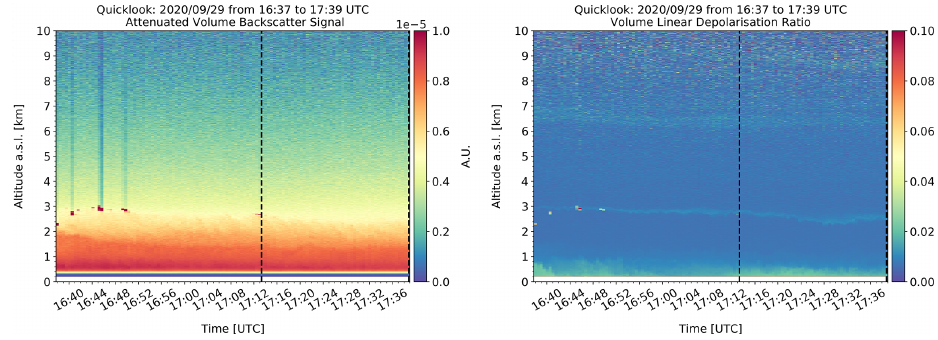
Figure 8. Height versus time plots of the attenuated volume backscatter signal from linear emission and the volume linear depolarisation ratio at 355nm over Athens, measured by eVe lidar on 29 September 2020 from 16:37 to 17:39UTC. The raw temporal and vertical resolution are 30s and 3.75m, respectively, with vertical pointing of the system. The attenuated volume backscatter signal was calibrated using a calibration factor averaged inside the selected time frame and calculated at 3.8km with a 0.3km window. The two dashed black lines enclose the selected time frame for the optical products’ retrieval. Table 2. The G , H , and K parameters with their uncertainties that were used for the retrieval of the VLDR and VCDR profiles on 29 Septem- ber 2020 from the A1 and B2 lidar configurations, respectively. The ideal G , H , and K values for each configuration are also provided (Freudenthaler,